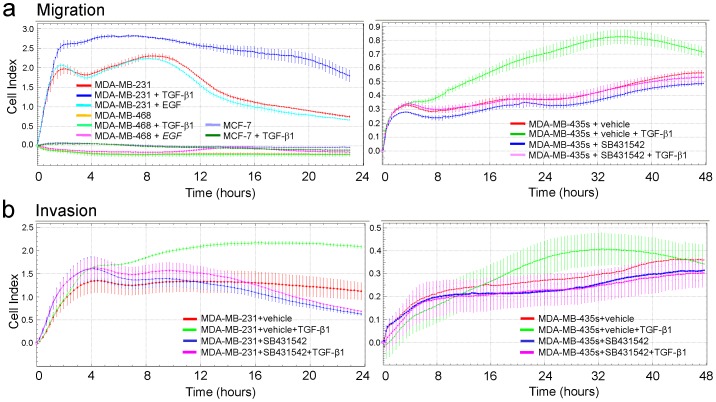
Real-time measurement of cell migration and cell invasion in various established breast carcinoma cell lines using the xCELLigence DP system.
a, left panel, Migration analysis of MDA-MB-231, MDA-MB-468, and MCF-7 cells. Cells were stimulated with either TGF-β1 (5 ng/ml) or EGF (20 ng/ml) as indicated by the color code in serum-reduced medium during the assay. At the 8, 16, 24, 32, and 40 h time points differences were highly significant (p<0.001) between control (red curve) and TGF-β1-treated (blue curve) but not between control and EGF-treated (cyan curve) MDA-MB-231 cells. Right panel, Migration curves of MDA-MB-435s cells in the presence of the ALK5 inhibitor SB431542 (5 µM) or vehicle-only (0.05% DMSO). At the 16, 24, 32, and 40 h time points differences were highly significant (p<0.001) between SB431542+TGF-β1-treated (pink curve) and vehicle+TGF-β1-treated (green curve) MDA-MB-435s cells. b, Matrigel invasion RTCA assay with MDA-MB-231 cells (left panel) and MDA-MB-435s cells (right panel) with or without TGF-β1 stimulation (5 ng/ml). Both cell lines were treated with TGF-β1 in the presence of either vehicle-only (0.05% DMSO) or the ALK5 inhibitor SB431542 (5 µM). In order to prepare the CIM-Plates 16 for the invasion setup, the bottom of the upper compartment of each well was covered with a thin layer of Matrigel prior to cell seeding. Data are depicted as mean ± SD of three or four wells processed in parallel. In each panel, a representative experiment is shown. At the 8, 12, 16, and 20 h time points differences were highly significant (p<0.001) between control (red curve) and TGF-β1-treated (green curve) MDA-MB-231 cells. Differences were significant (p<0.05) between SB431542+TGF-β1-treated cells (pink curve) and vehicle+TGF-β1-treated cells (green curve) at the 12, 16, and 20 h time points (MDA-MB-231, left panel) and at the 24, 32, and 40 h time points (MDA-MB-435s, right panel).